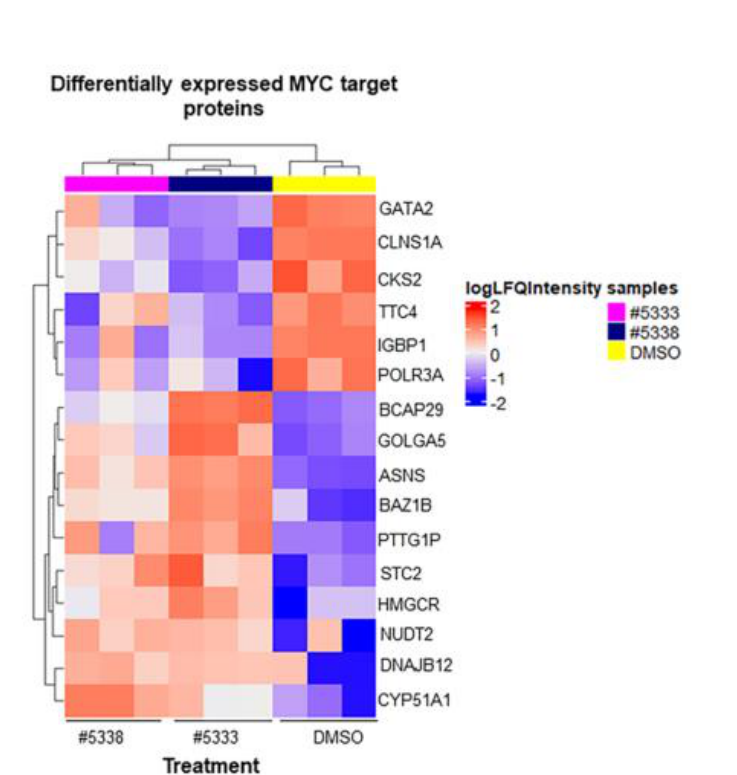
Figure 4. Label-free quantitative mass spectrometry of differentially expressed proteins from neu- roblastoma cells following treatment with compounds #5333 or #5338. ( A , B ) SK-N-BE(2)-C cells were treated with 2 x the IC50 concentrations of #5333, #5338, or DMSO control and were incubated for 72 h, followed by total protein lysate collection and analysis using LCMS/MS. Three biological replicates were processed and analysed for each group. Volcano plot of the differentially expressed proteins of ( A ) #5333- and ( B ) #5338-treated cells compared to DMSO. ( C , D ) Downregulated Gene Ontology (GO) biological processes − log10 p value bar plots for ( C ) #5333- and ( D ) #5338-treated cells. ( E ) Known MYC target genes modified by #5333 or #5338 treatment.